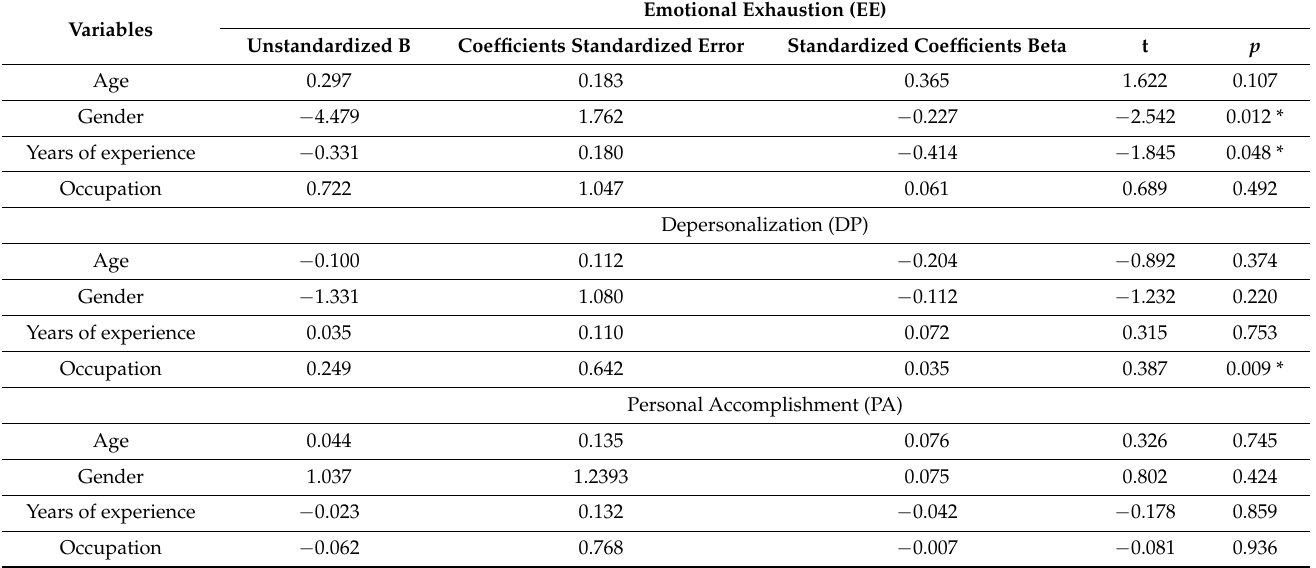
Table 5. Prevalence of burnout depending on variables (age, gender, years of experience and occupation). The linear regression model was used to calculate the influence of the continual variables and the chi-square test in case of categorical variables.